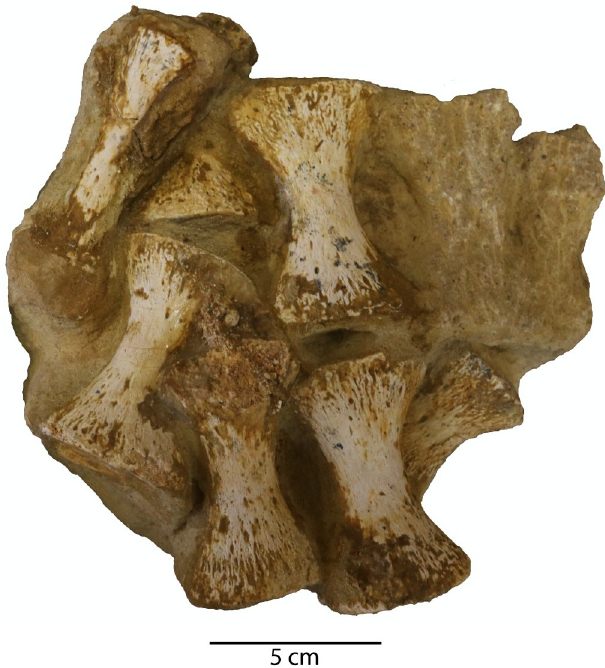
Fig 26. Semi-articulated phalanges of Cardiocorax mukulu (MGUAN PA278).